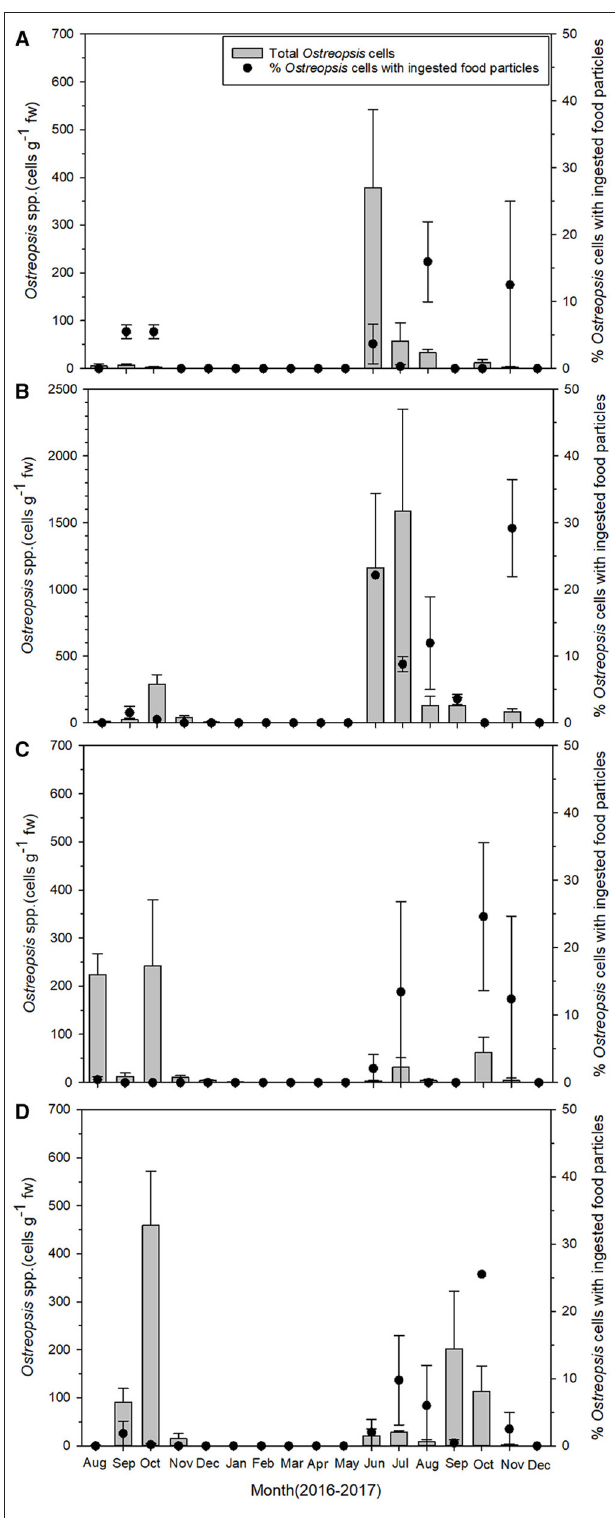
FIGURE 3 | Temporal pattern of total Ostreopsis spp. abundance (gray bars) on macrophytes and the percentage of Ostreopsis cells with ingested food particles (closed circles) during the study period at (A) Gangsa, (B) Samjeong, (C) Guryongpo, and (D) Hajeong. Data are given as mean ±